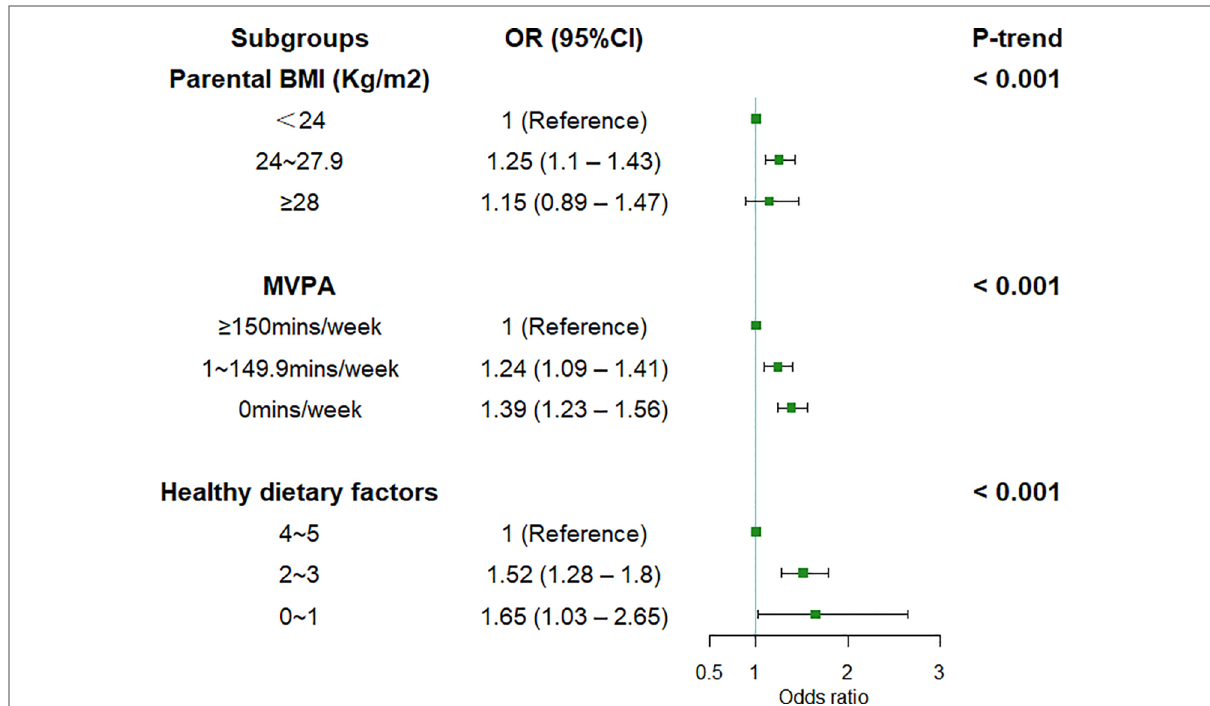
FIGURE 3 Association between different levels of single behavior of parents and offspring ’ s nonideal CVH status. Error bar was 95% CI. Multilevel logistic regression was used, and CVH status was de fi ned as nonideal status or ideal CVH status. Data adjusted for provinces, resident area, family history of chronic diseases, family monthly income, offspring ’ s sex, age, birth weight, single-child status, breast feeding status, and parental highest education attainment. CVH, cardiovascular health; BMI, body mass index; MVPA, moderate to vigorous physical activity; OR, odds ratio; CI, con fi dence interval.